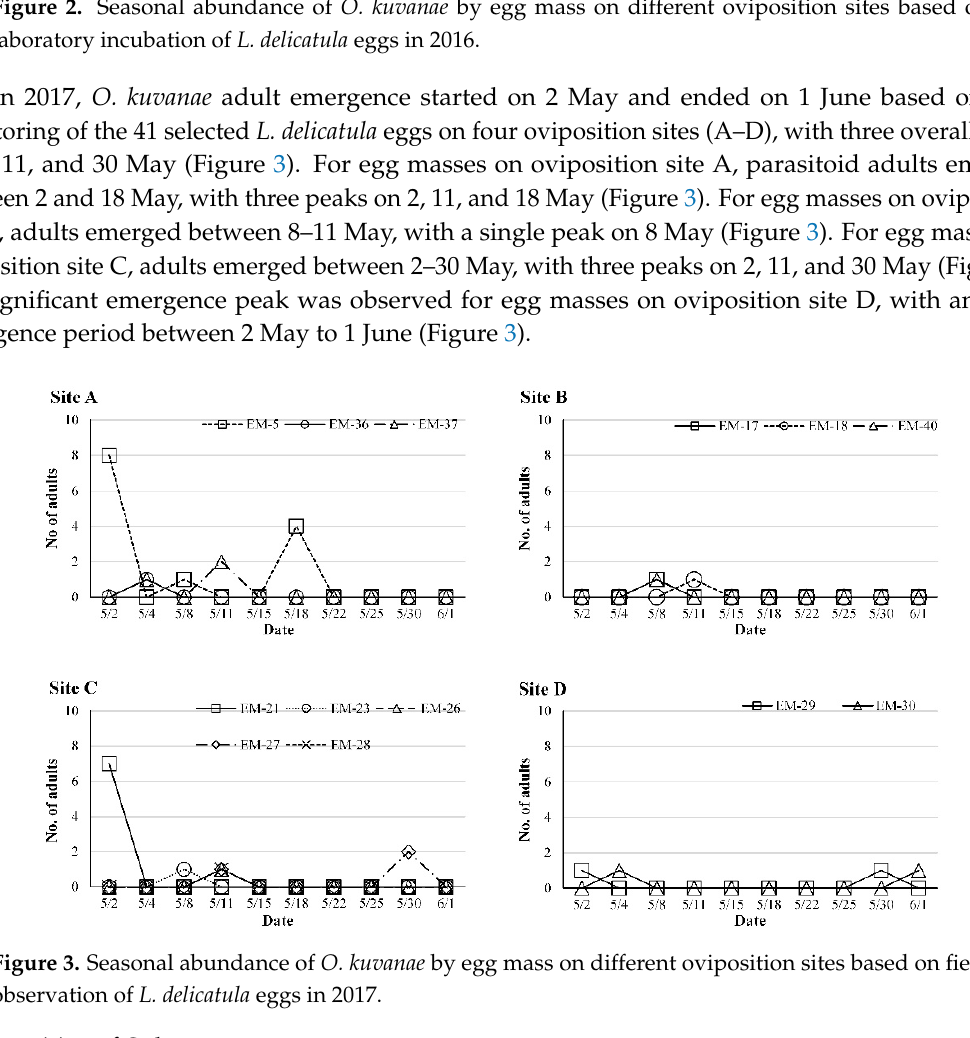
Figure 3. Seasonal abundance of O. kuvanae by egg mass on different oviposition sites based on field observation of L. delicatula eggs in 2017.